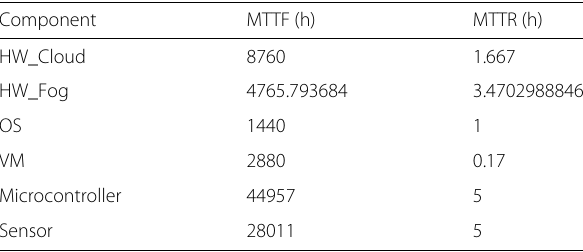
Table 7 MTTF and MTTR of components in hours (values obtained from [53–58])